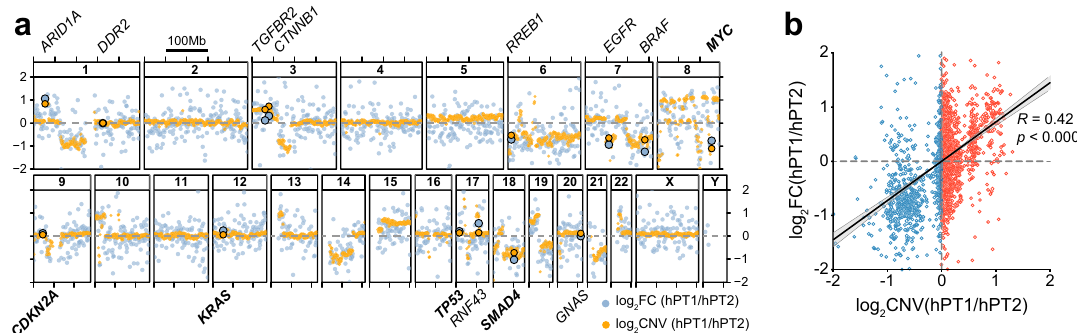
Fig. 4 Copy number alterations translate to transcript regulations. a Both hPT1 P3 and hPT2 P6 organoids were subjected to RNA-seq. The gene expression fold change (log 2 FC, blue) between the two was averaged for every 1 Mb region across the whole genome. The plot shows good accordance between the gene expression fold change and the copy number variations (log 2 CNV from SNPa copy number pro fi les, orange) of the two organoids, especially in chromosomes 1, 3, 6, 7, 10, 14, 15, 19, and 21. The general agreements between log 2 FC and log 2 CNV are also observed for the commonly mutated genes in PDAC. b The CNV of each 1 Mb region was plotted against the corresponding gene expression fold change, resulting in a positive correlation between CNV and gene expression fold change. The correlation has a Pearson correlation coef fi cient ( R ) of 0.42, which is statistically signi fi cant, with p <